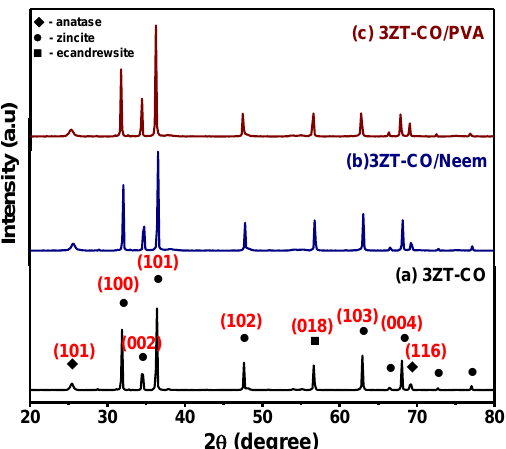
Figure 1. The XRD pattern of ( a ) the non-functionalized nanoparticles, 3ZT-CO, and the stabilized nanoparticles ( b ) 3ZT-CO/Neem and ( c ) 3ZT-CO/PVA. The morphology of 3ZT-CO, 3ZT-CO/Neem, and 3ZT-CO/PVA were examined by SEM and the